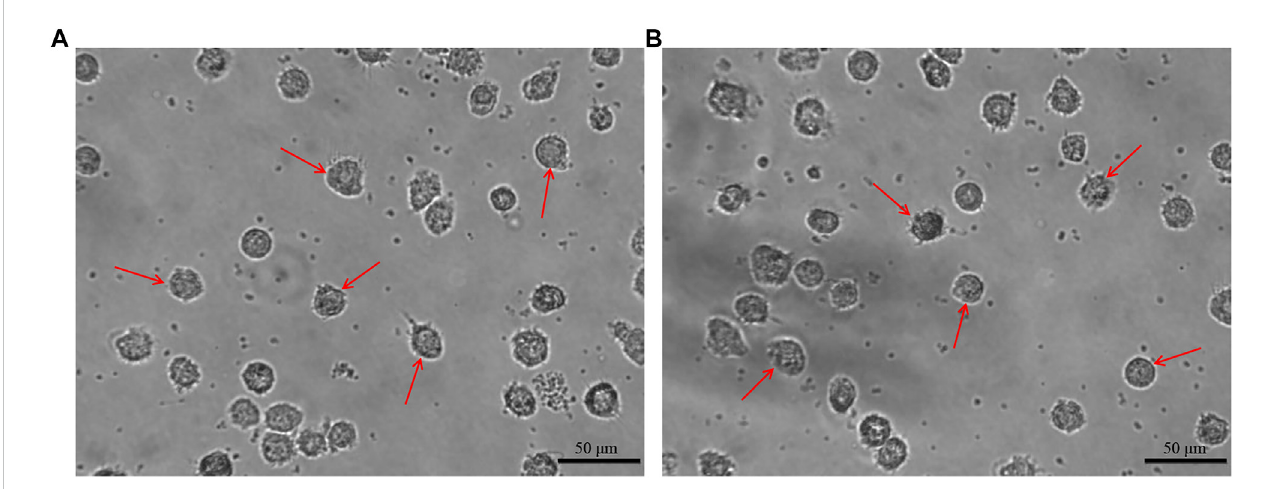
FIGURE 2 The morphology of moDCs. The moDCs derived from a HD and a MM patient are shown in fi gure (A, B) respectively, which are large, irregular in shape with obvious dendritic